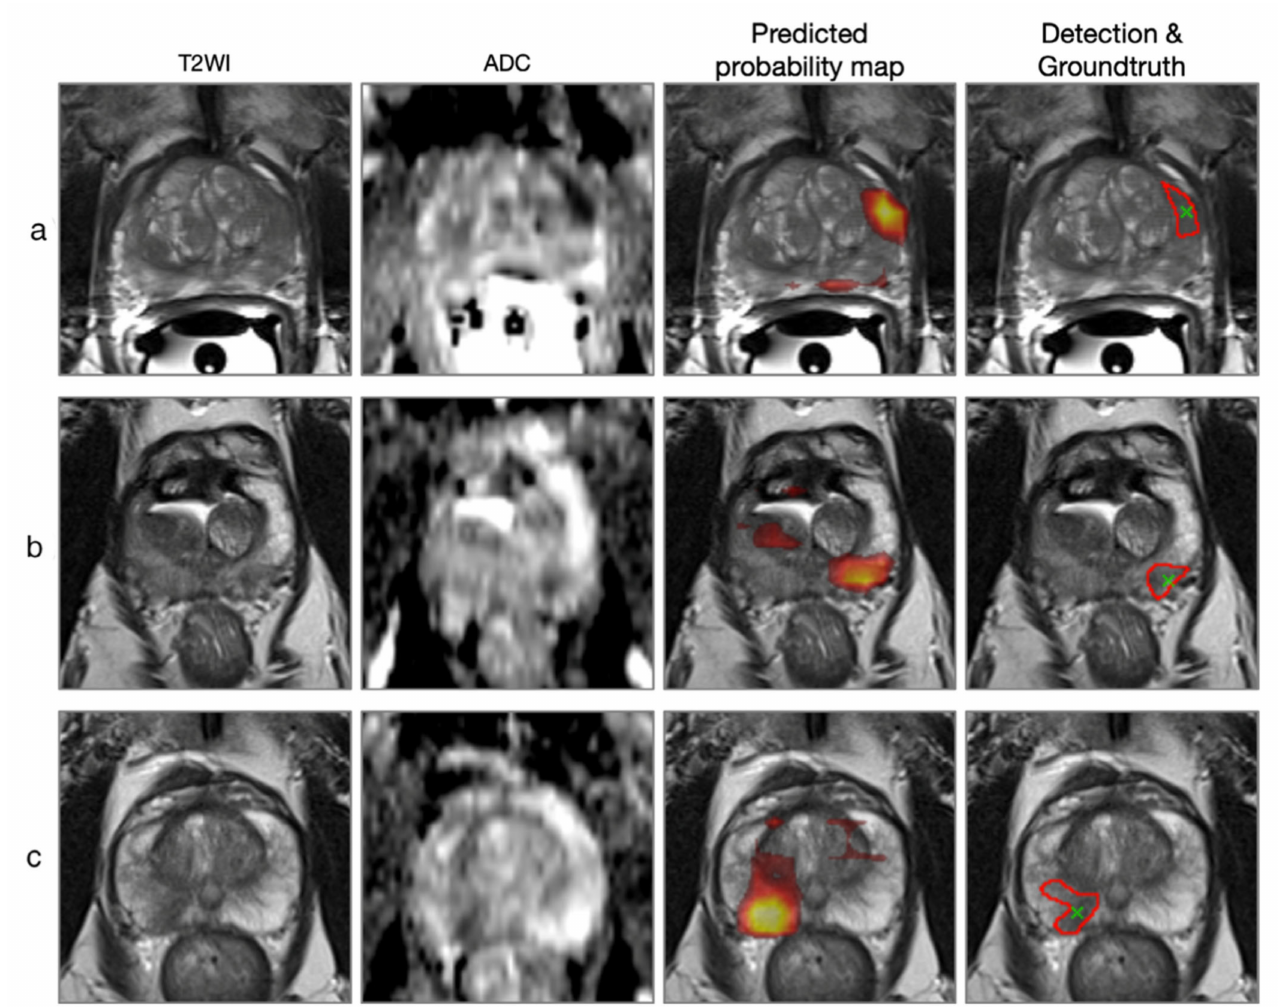
Figure 6. “Examples of lesion detection. The left two columns show the input T2WI and ADC map, respectively. The right two columns show the FocalNet-predicted lesion probability map and detection points (green crosses) with reference lesion annotation (red contours), respectively. ( a ) Patient at age 66, with a prostate cancer (PCa) lesion at left anterior peripheral zone with Gleason Group 5 (Gleason Score 4 + 5). ( b ) Patient at age 68, with a PCa lesion at left posterolateral peripheral zone with Gleason Group 2 (Gleason Score 3 + 4). ( c ) Patient at age 69, with a PCa lesion at right posterolateral peripheral zone with Gleason Group 3 (Gleason Score 4 + 3). ADC = apparent diffusion coefficient; T2WI = T2-weighted imaging“(reprinted with permission from [72], Copyright 2021 John Wiley and